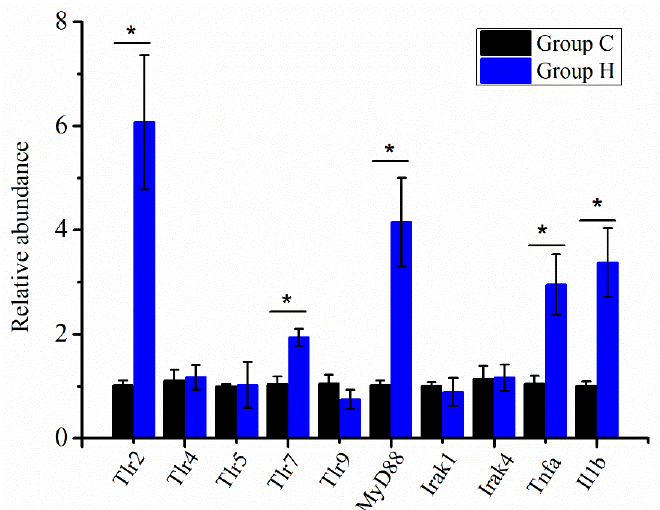
Figure 6. Expression of immune-related genes in intestinal tissue on day 14. The results were ana- analyzed using the 2 − ∆∆ Ct method, and the 2 – ∆∆ Ct of genes in the group C was set as 1. * Indicates lyzed using the 2 −ΔΔCt method, and the 2 –ΔΔCt of genes in the group C was set as 1. * Indicates that that there was significant difference between groups ( p < there was significant difference between groups ( p < 0.05).